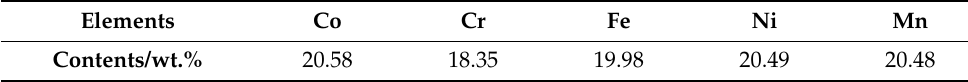
Table 1. Elemental composition of CoCrFeNiMn HEA powder.